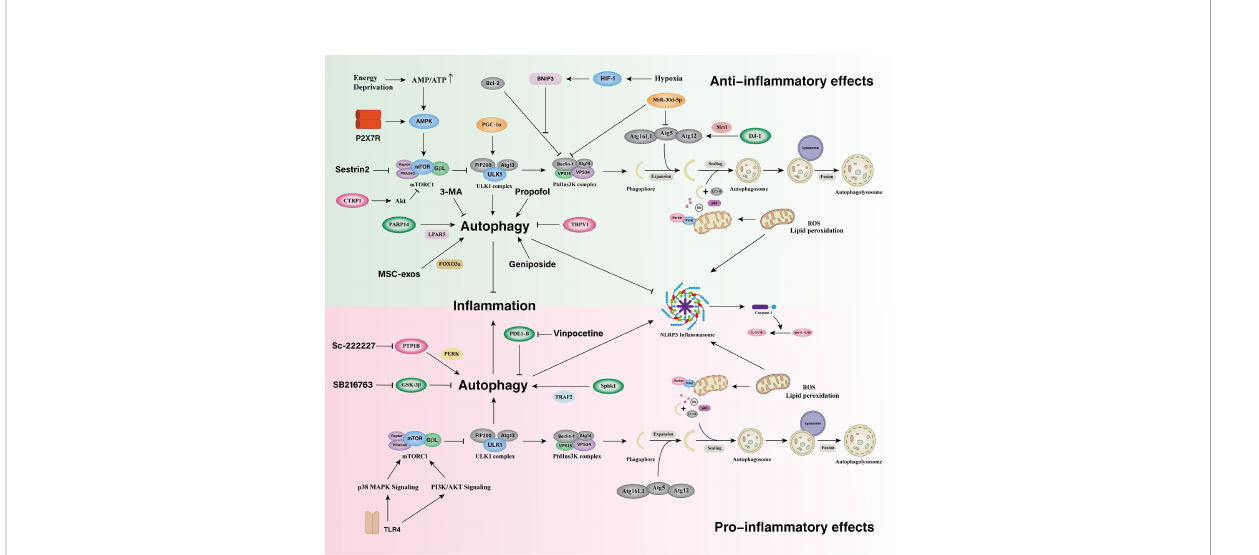
FIGURE 3 Microglia autophagy in the regulation of in fl ammatory responses in ischemic stroke. Microglial autophagy bidirectionally regulates in fl ammatory responses and there are complex interactions between them in ischemic stroke. The downregulation of Microglial PDE1-B, GSK-3 b , and the upregulation of PARP14 promote microglia autophagy and suppress in fl ammatory responses. The upregulation of PGC-1 a promotes autophagy and mitophagy via ULK1 and inhibits the overactivation of NLRP3 in fl ammasome. DJ-1 activates the Atg5-Atg12-Atg16L1 complex via Sirt1 and alleviates in fl ammatory responses. HIF-1 regulates the expression of BNIP3, induces autophagy by disrupting the interaction of Beclin1 with Bcl- 2 and suppresses microglia in fl ammatory cytokine overexpression during early hypoxia. Activation of autophagy via the AMPK pathway can facilitate microglia alternatively activation and exert neuroprotective effects during an in fl ammatory process. P2X7 receptor can activate AMPK pathways in the regulation of mitochondrial and lysosomal functions in microglia. Sestrin2 promote microglia autophagy via inhibiting mTOR pathway to attenuate microglial in fl ammatory response. The upregulation of TRPV1 and CTRP1 inhibit autophagy and reduces the in fl ammatory response. MiR-30d-5p inhibits Beclin-1 and ATG5 expression and exerts an anti-in fl ammatory effect. Microglial PTP1B, SphK1, and TLR4 induce autophagy and promote microglial proin fl ammatory